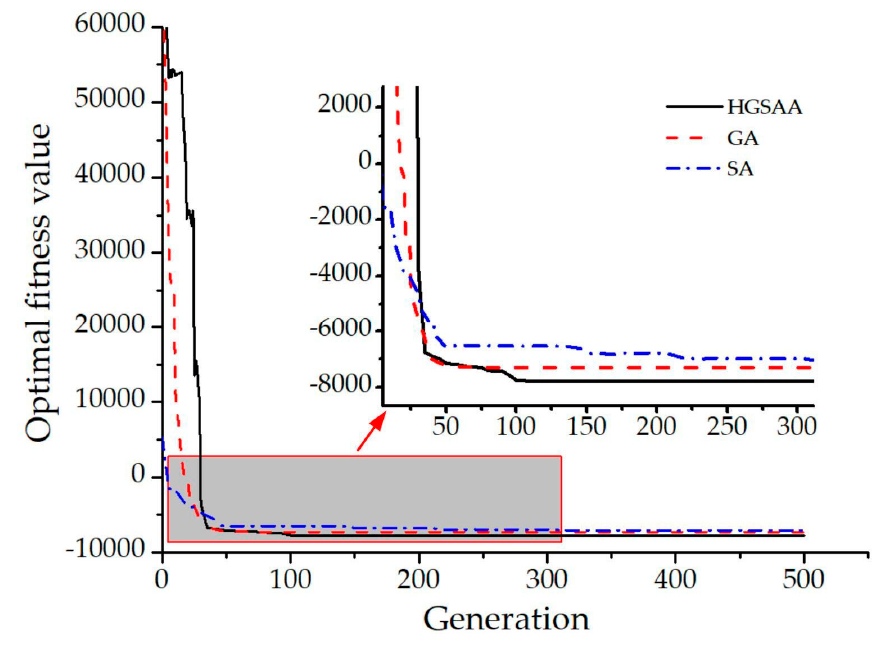
Figure 10. The fitness evolutionary curves of HGSAA, GA, and SA. Table 3. The HGSAA optimization results of structural parameters of the pressure hull.